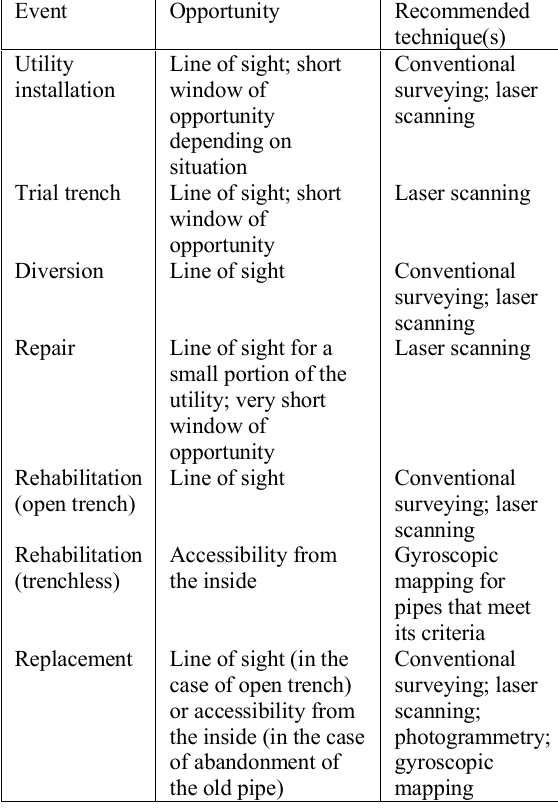
Table 2. Utility life cycle events and potential data capture opportunities and